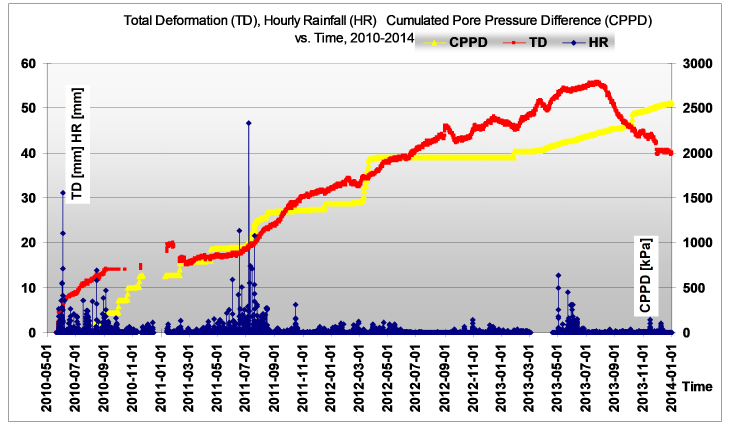
Figure 7. Results of on-line displacement, rainfall and pore pressure measurements, Szymabark.